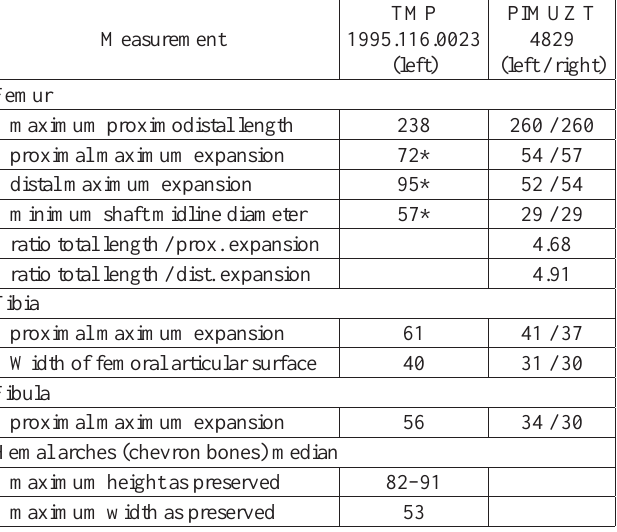
Table 1. Measurements (in mm) of TMP 1995.116.0023 tentatively identified as Nothosauroidea and PIMUZ T 4829 (= holotype of Paran- othosaurus amsleri Peyer, 1939, 385 cm in total body length) of Notho- saurus giganteus for comparison based on measurements from Peyer (1939). For the ratios in the latter, the mean of left and right femur were taken. * Note that the femur of TMP 1995.116.0023 experienced com- paction, which likely causes the bone to appear wider and more robust as in during life; we thus refrain from providing ratios for the